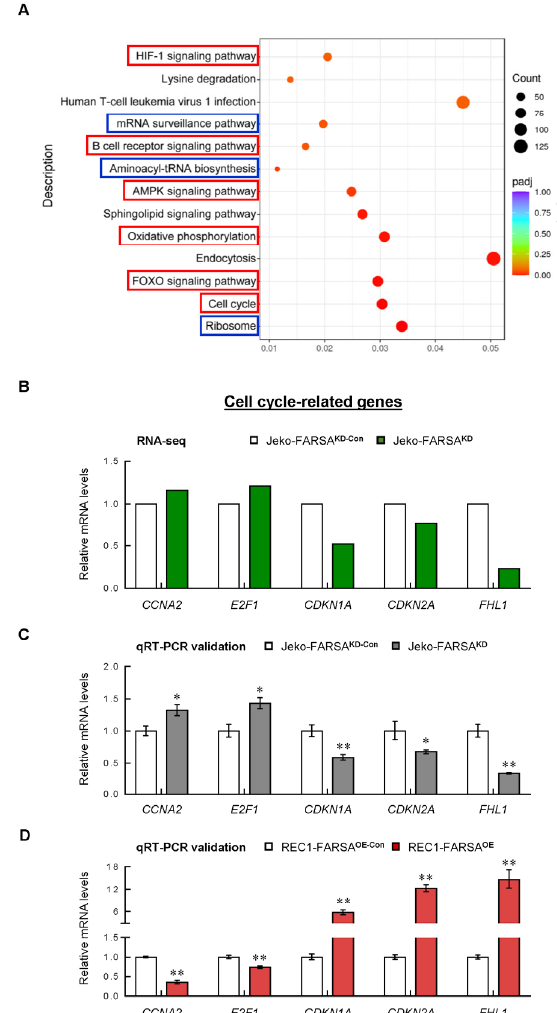
Figure 5. The enriched Kyoto Encyclopedia of Genes and Genomes (KEGG) pathways and validation experiments of cell cycle-related genes. ( A ) KEGG pathway enrichment scatter plot, with blue boxes indicating the canonical pathways and red indicating the cancer-related pathways. The vertical axis represents the pathway name, and the horizontal axis represents the pathway factor corresponding to the Rich factor. The size of the adjusted p value is represented by the color of the point. The smaller the adjusted p value, the closer the color is toward red. The number of the DEGs included in each pathway are expressed by the size of the point. ( B ) Relative mRNA levels of the selected cell cycle-related DEGs from the RNA-seq. Each value from the RNA-seq in FARSA KD Jeko cells was relative to the control cells. Validation experiments in FARSA KD Jeko cells ( C ) and FARSA OE REC1 cells ( D ). Each value from qRT-PCR was normalized to ACTB and is presented as the mean ± SD. * p < 0.05; ** p < 0.01 (vs. control